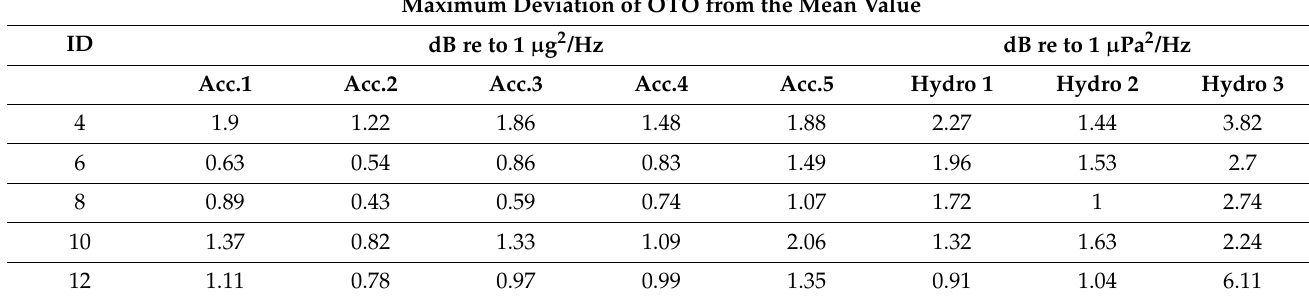
Table 2. Maximum deviation between the mean value of each OTO and real values for all sensors and measurements. ID is the identification number of each